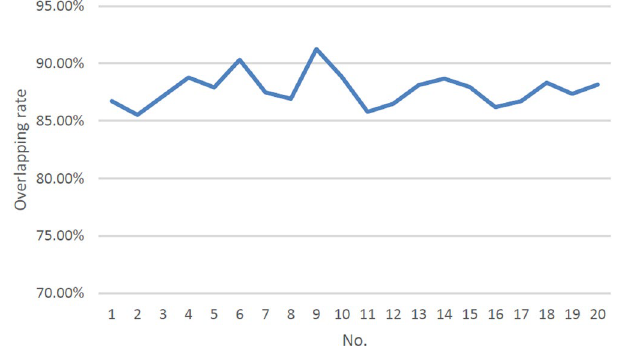
Figure 6. The overlapping rate of implant design for twenty times in the same